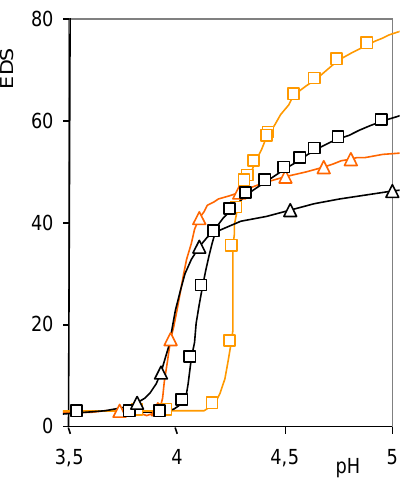
Figure 2. Equilibrium degree of swelling (EDS) in relation to pH for the hydrogel AVa-2 (red lines) and AVa-5 (dark lines) at 25 °C and different ionic strengths: 0.05 M acetate buffer (squares) and 0.01 M acetate buffer in 0.15 M NaCl (triangles).